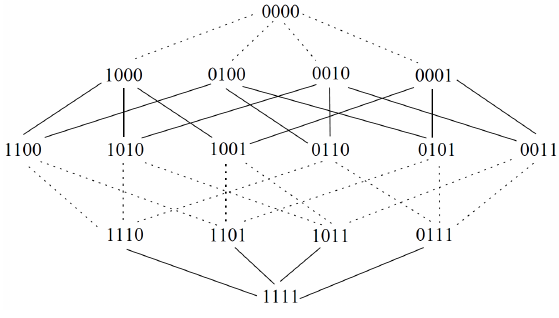
Figure 5: A red-blue coloring of Q 4 avoiding a monochromatic C 4